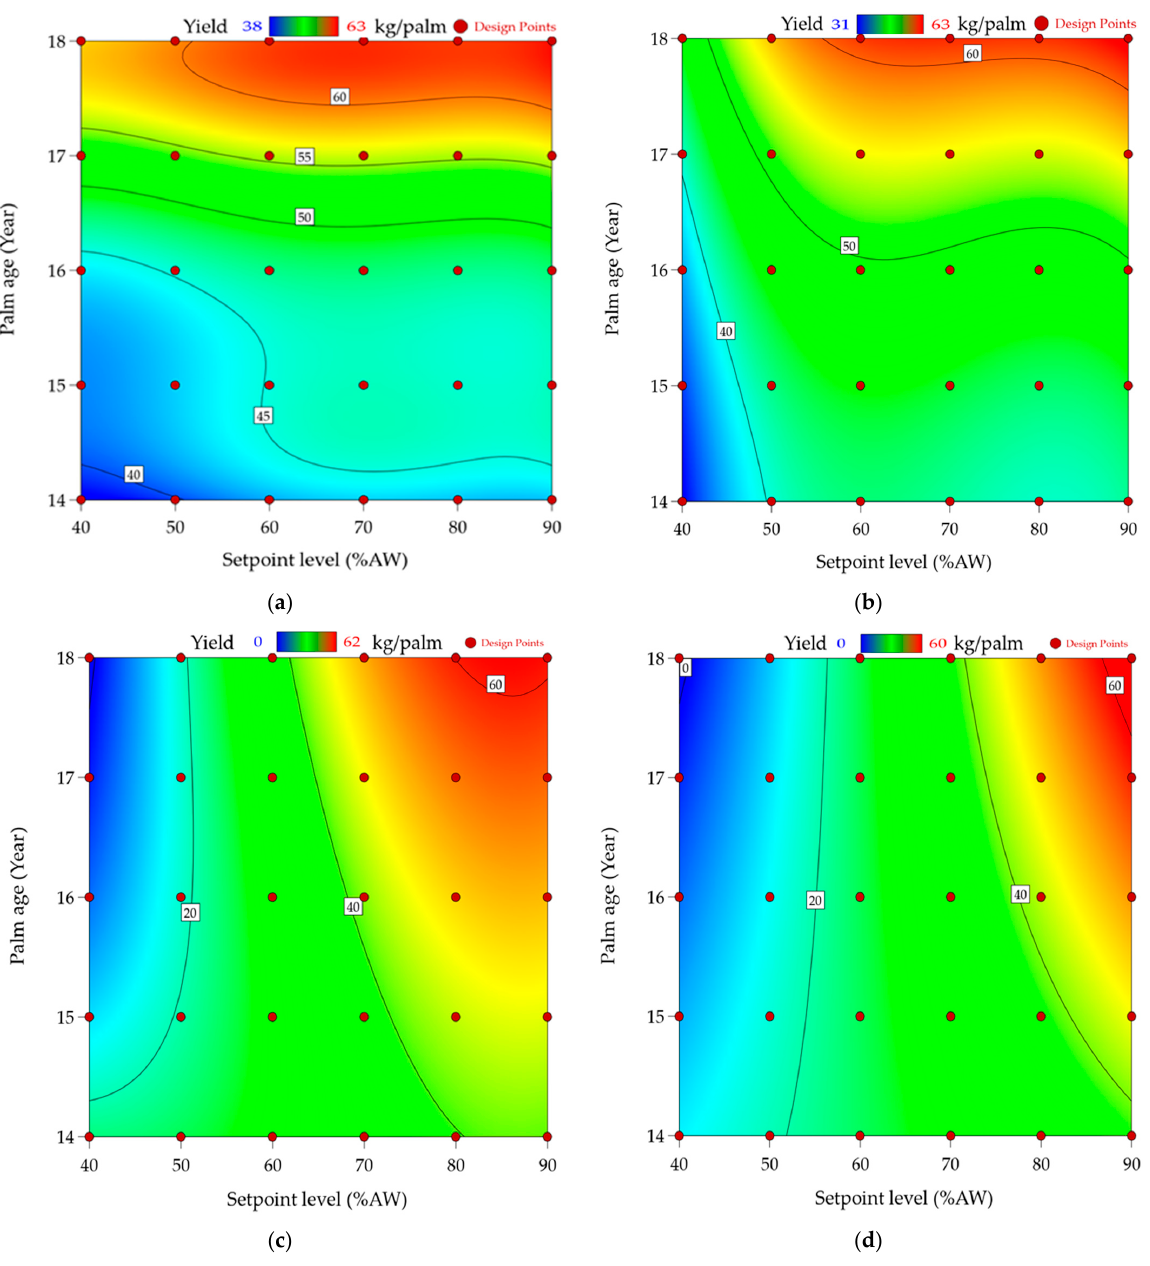
Figure 7. Effect of irrigation water levels at the different minimum irrigation control setpoints (%AW) and palm ages (year) on palm tree yield cv. Khalas (kg/palm) under different micro irrigation systems, i.e., ( a ) subsurface irrigation system, ( b ) subsurface drip irrigation system, ( c ) drip irrigation system, and ( d ) bubbler irrigation system.